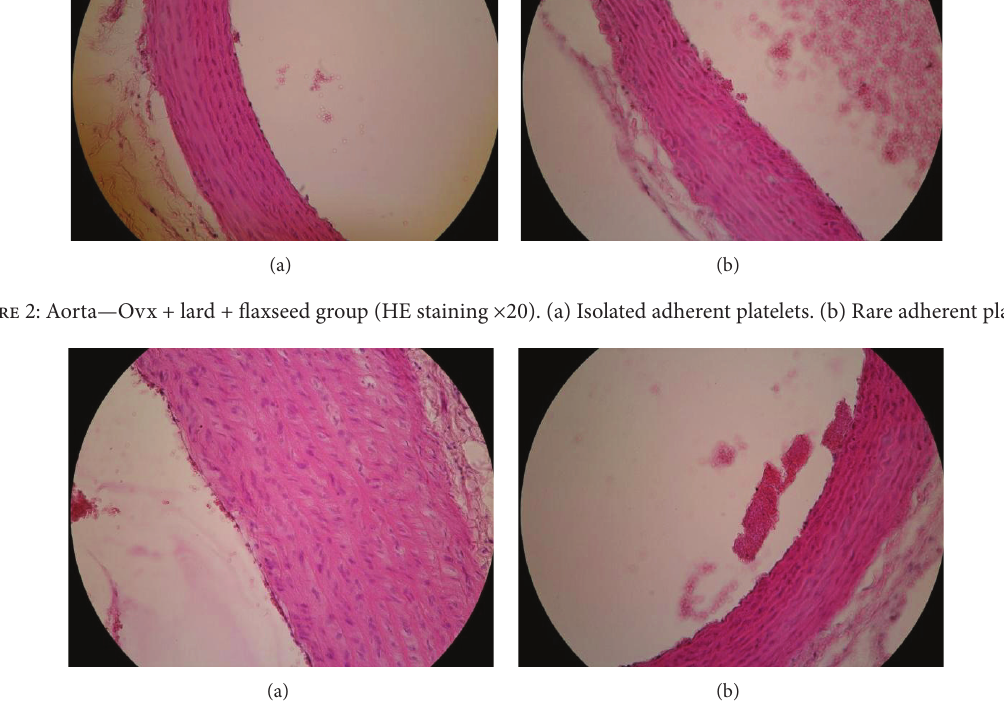
Figure 3: Aorta—Sham + lard + flaxseed group (HE staining × 20). (a) Rare adherent platelets. (b) No platelets adhered to the